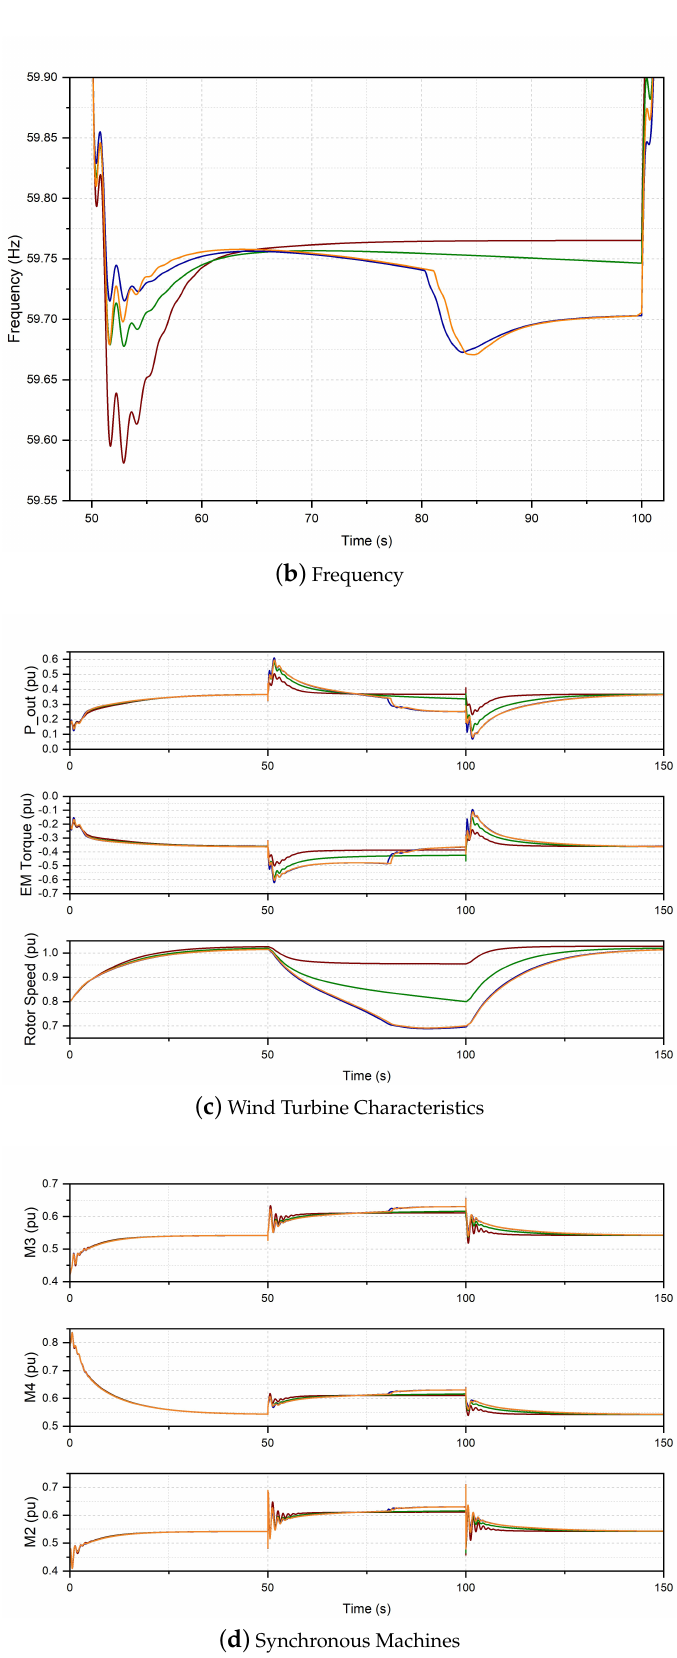
Figure 4. Variations in grid frequency, WTs’ and synchronous machines’ responses during different inertial and droop control